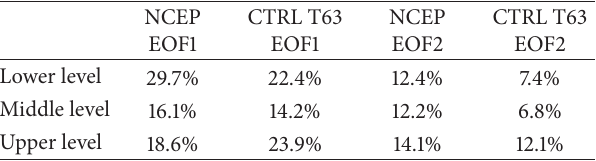
Table 2: Explained percentage of total variance by the dominant variability patterns (EOF1 and EOF2) for reanalysis data and the control run of the quasi-geostrophic model with T63 resolution.